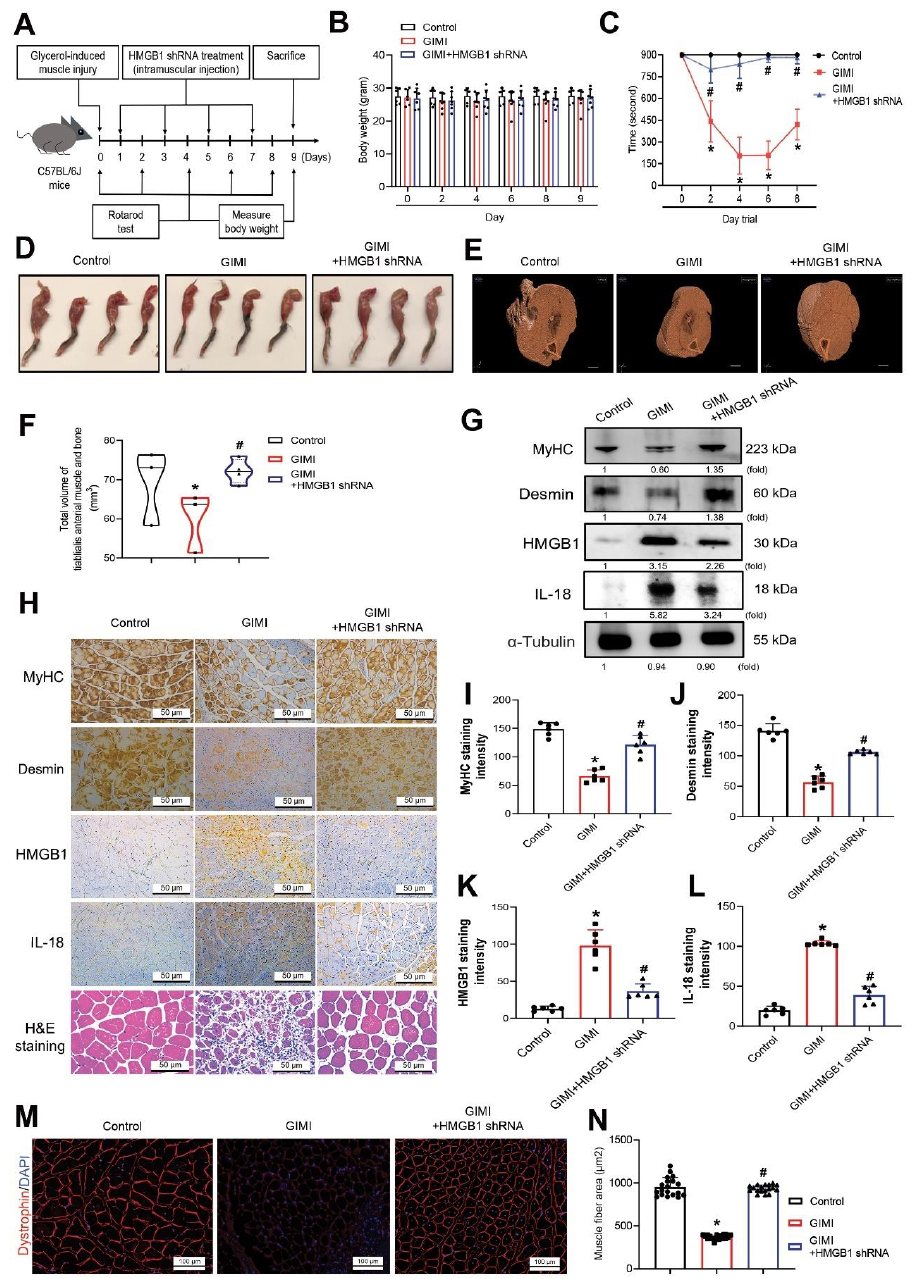
Figure 6. Downregulating HMGB1 rescues skeletal muscle atrophy in the glycerol-induced muscle injury (GIMI) mouse model. ( A ) The mice were randomly separated into three groups: control, GIMI, or GIMI + HMGB1 shRNA ( n = 10 mice/group). Muscle injury was induced in 8-week-old male C57BL/6J mice via intramuscular injection of glycerol (70 µL of 50%, v/v ) into tibialis anterior (TA) muscle on Day 0. Mice received a single injection of HMGB1 shRNA (70 µL) into the TA muscle on Days 1, 3, 5, and 7. ( B ) Bodyweight was measured on Days 0, 2, 4, 6, 8, and 9. ( C ) Muscle function was evaluated by rotarod testing ( n = 10). ( D ) The gross hindlimb musculature of mice in the control group, GIMI group and GIMI with HMGB1 shRNA treatment group. ( E ) Micro-CT scan of TA muscle after PTA staining. ( F ) Total volume of TA muscle and bone were evaluated by micro-CT ( n = 3). ( G ) Western blot identifica- tion of MyHC, desmin, HMGB1, and IL-18 protein from TA muscle tissue lysates of the control group, GIMI group and GIMI +